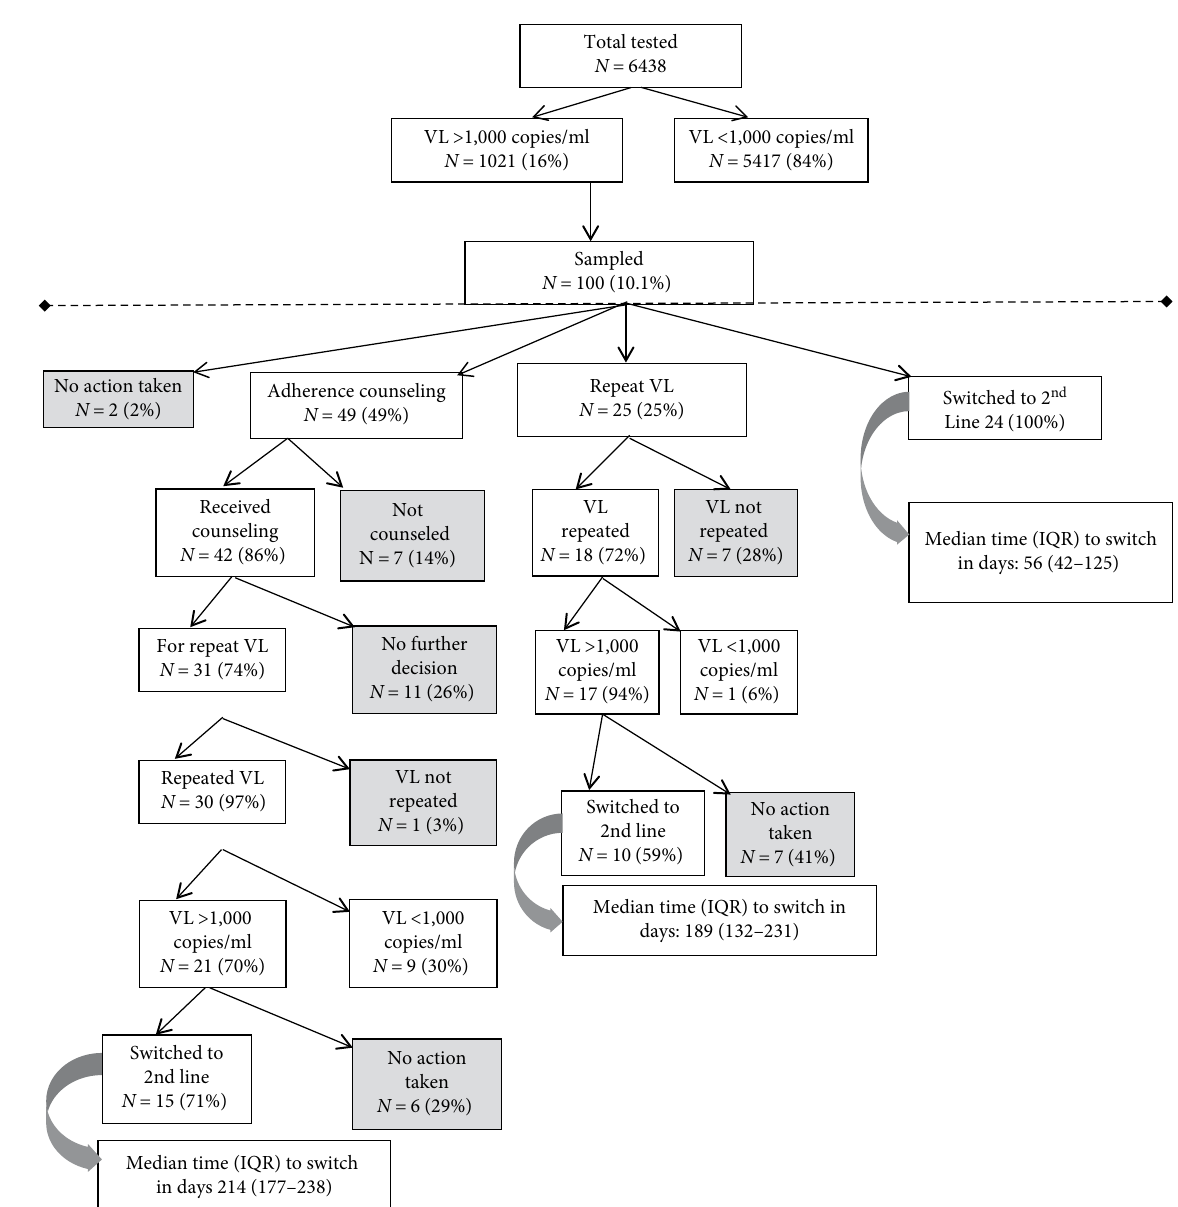
Figure 2: Demonstration of the number of patients who had detectable viral loads and the actions taken for the 100 patients following the IDI treatment failure pathway algorithm including the proportions of patients who were referred for adherence counselling, VL retesting, 2nd line switches and those who had no action